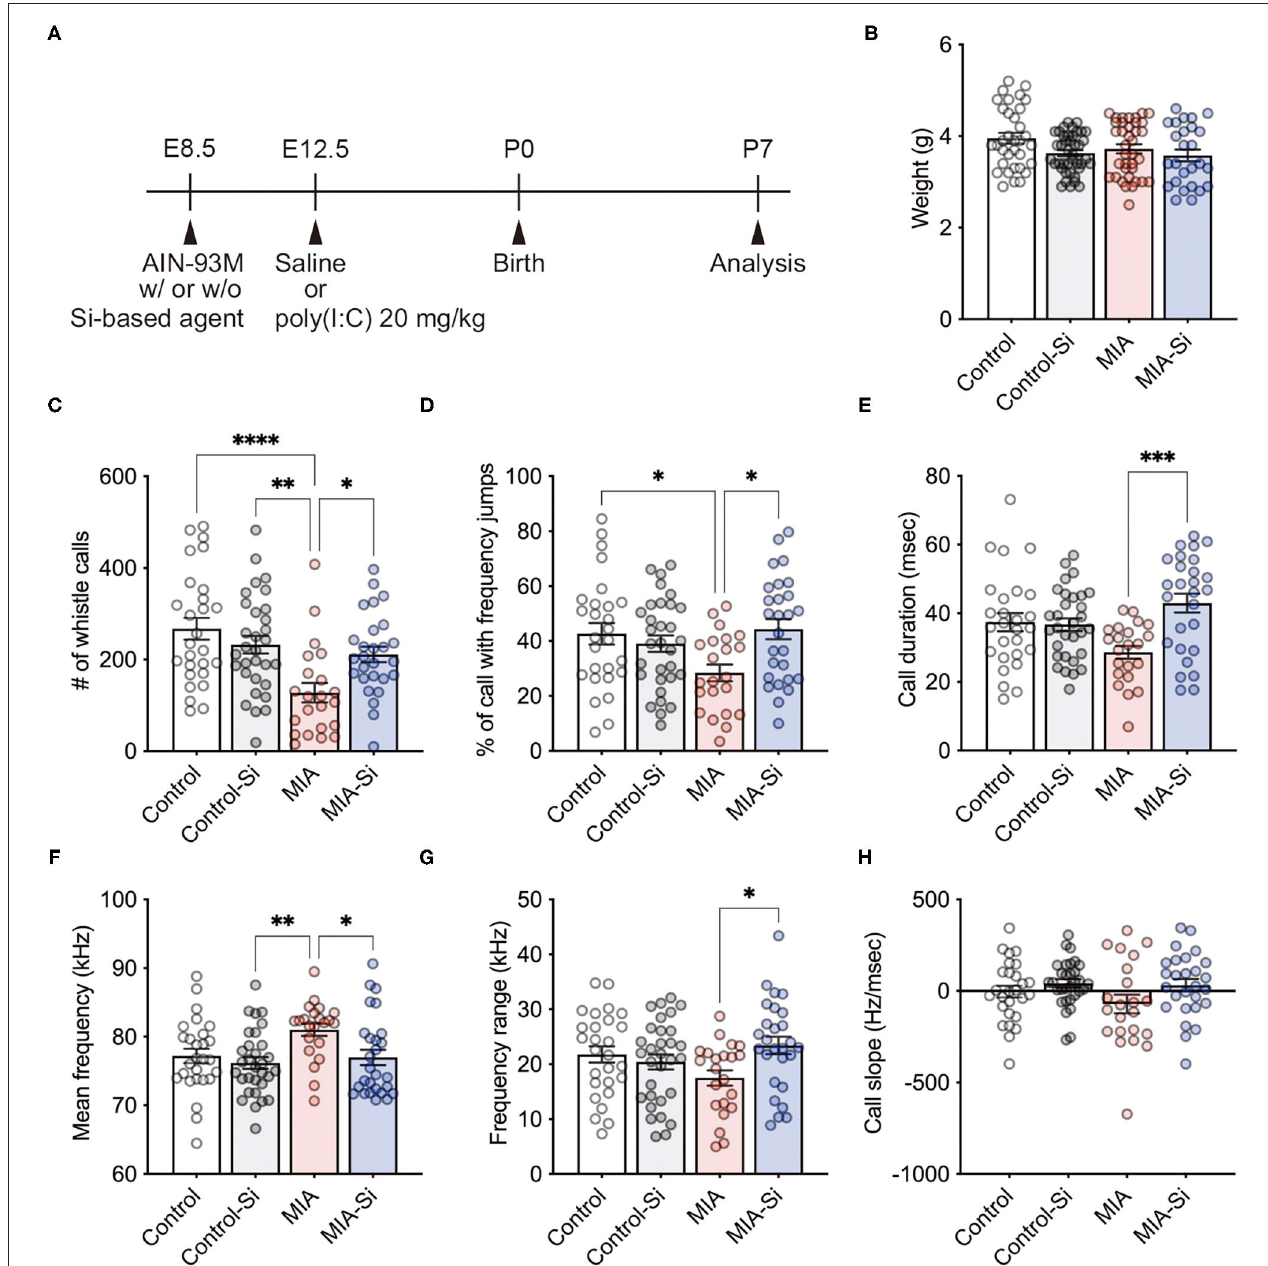
FIGURE 1 | Silicon-based agent improved social communication of MIA offspring. (A) Experimental scheme. Pregnant mice were fed the AIN-93M diet with or without 2.5 weight% Si-based agent from E8.5 until P7. Saline or poly(I:C) (20 mg/kg) was intraperitoneally injected into pregnant mice at E12.5. (B) No change in the weight (interaction: F = 0.82, DF = 1, P = 0.37; MIA: F = 2.02, DF = 1, P = 0.0205; Si: F = 5.50, DF = 1, P = 0.16). (C–H) Mouse ultrasonic vocalizations (USVs) in the MIA offspring. The number of whistle calls (interaction: F = 8.24, DF = 1, P = 0.0050; MIA: F = 15.37, DF = 1, P = 0.24; Si: F = 1.40, DF = 1, P = 0.0002) ( C ), % of call with frequency jumps (interaction: F = 7.90, DF = 1, P = 0.0059; MIA: F = 1.65, DF = 1, P = 0.08; Si: F = 3.16, DF = 1, P = 0.20) (D) , call duration (ms) (interaction: F = 10.26, DF = 1, P = 0.0018; MIA: F = 0.30, DF = 1, P = 0.0044; Si: F = 8.47, DF = 1, P = 0.58) (E) , mean frequency (kHz) (interaction: F = 2.25, DF = 1, P = 0.14; MIA: F = 5.41, DF = 1, P = 0.0127; Si: F = 6.43, DF = 1, P = 0.0220) (F) , frequency range (kHz) (interaction: F = 6.12, DF = 1, P = 0.0150; MIA: F = 0.19, DF = 1, P = 0.13; Si: F = 2.35, DF = 1, P = 0.66) (G) , and call slope (Hz/ms) (interaction: F = 0.71, DF = 1, P = 0.40; MIA: F = 1.27, DF = 1, P = 0.0342; Si: F = 4.61, DF = 1, P = 0.26) (H) were analyzed. In the MIA offspring, reduced whistle calls and calls with frequency jumps and increased mean frequency were observed, but those alterations in USVs were improved with a silicon (Si)-based agent, respectively. Si, Si-based agent; MIA, maternal immune activation. Data are presented as means ( ± SEM). **** P < 0.0001, *** P < 0.001, ** P < 0.01, * P < 0.05, one-way ANOVA with a Tukey’s multiple-comparison test. n = 26–41/condition for weight, n = 22–31/condition from